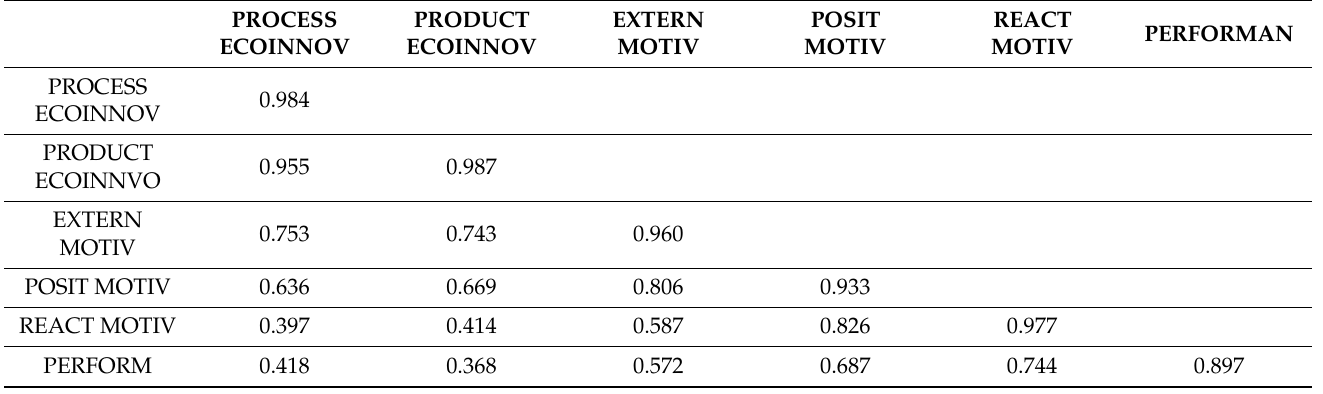
Table 3. Forner–Larcker